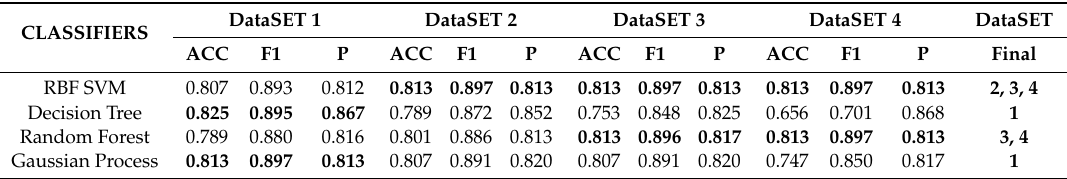
Table 6. Comparison of results.